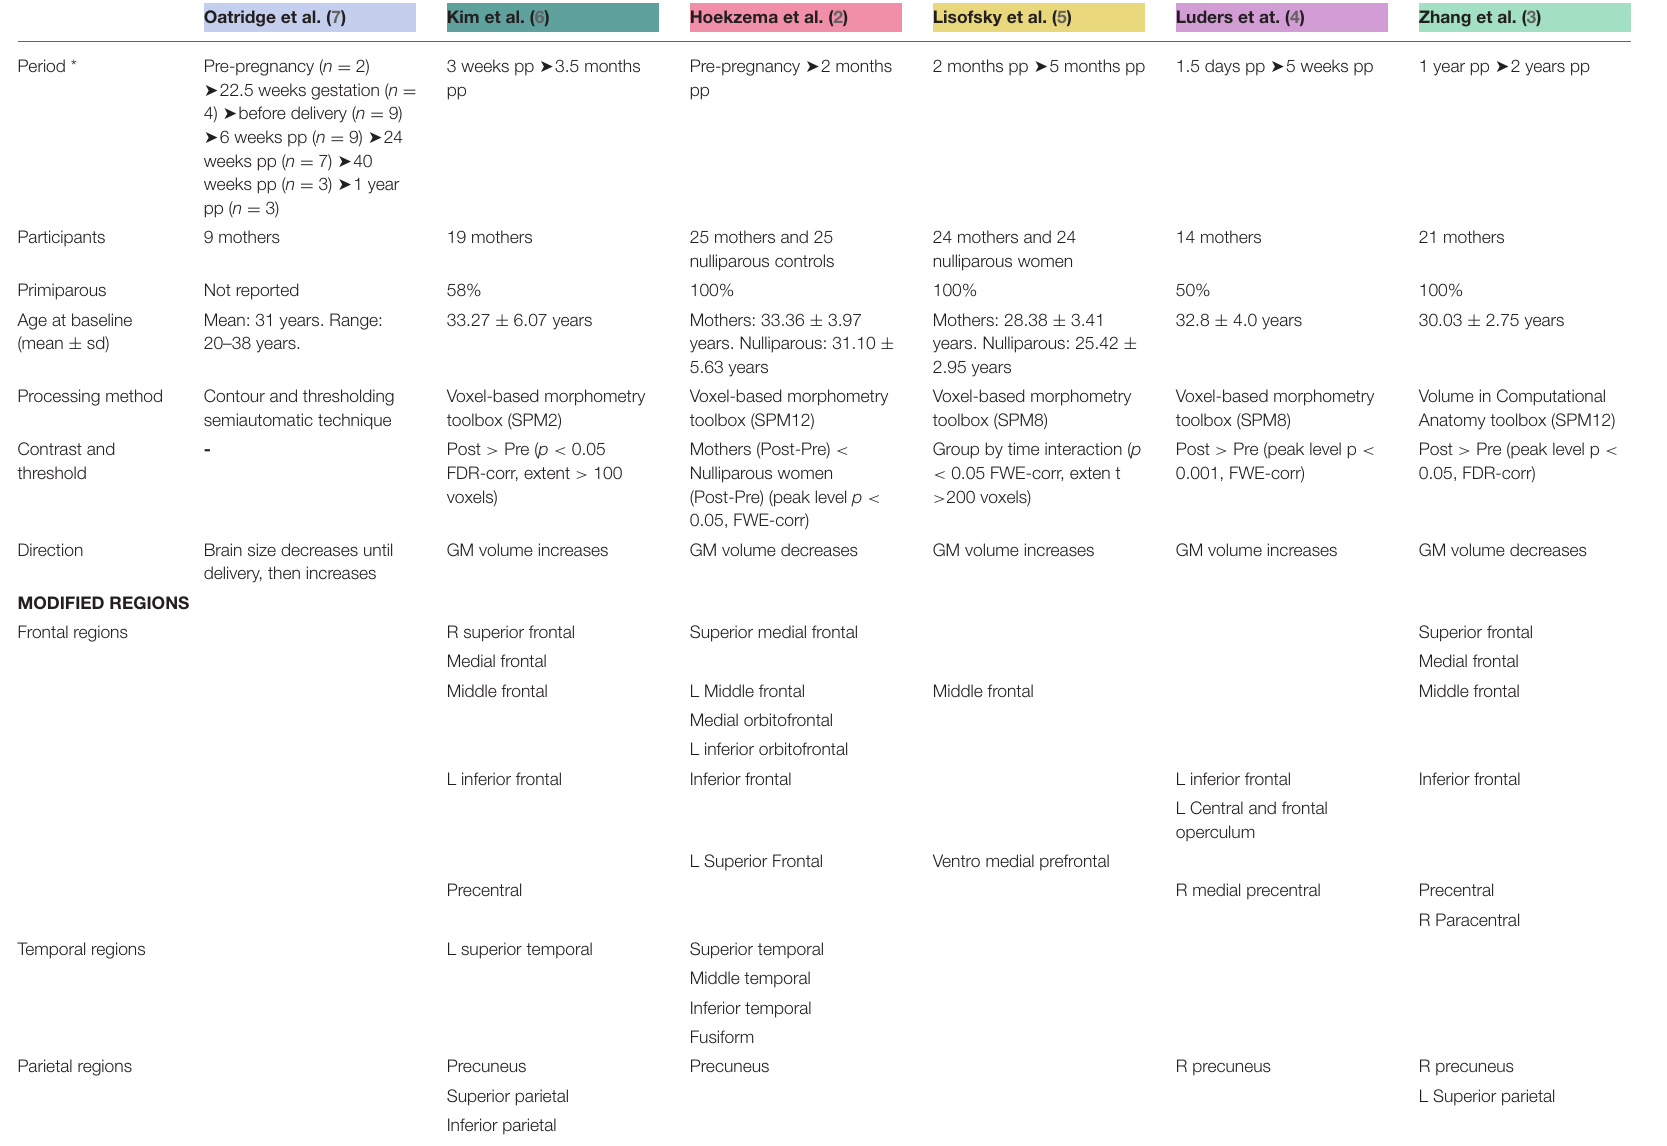
TABLE 1 | Summary of the characteristics and findings of the longitudinal MRI structural studies tracking the maternal brain. Oatridge et al.